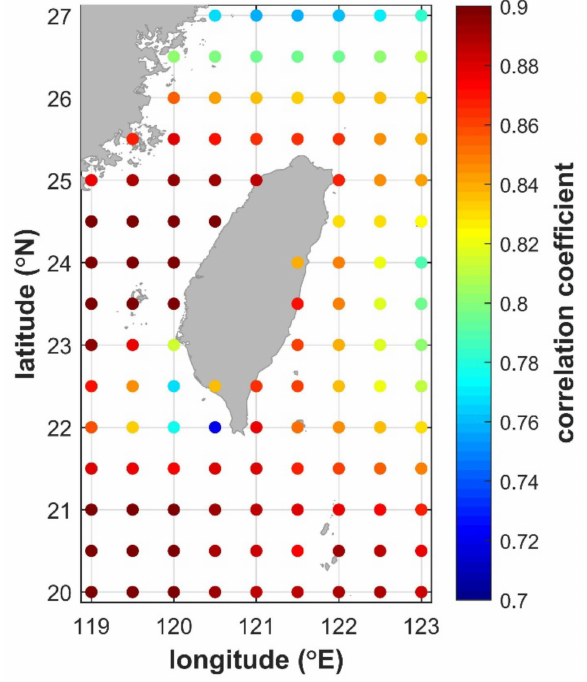
Figure 10. Results of the validation in terms of correlation coefficients. The spatial domain spans from 20 ◦ N to 27 ◦ N and 119 ◦ E to 123 ◦ E.